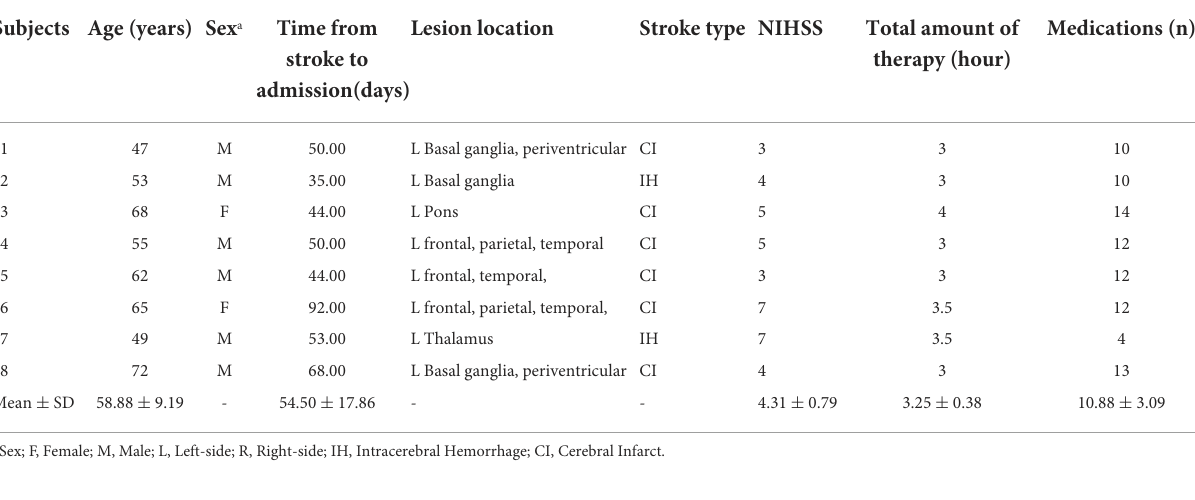
TABLE 1 General characteristics of persons with stroke ( n = 8).